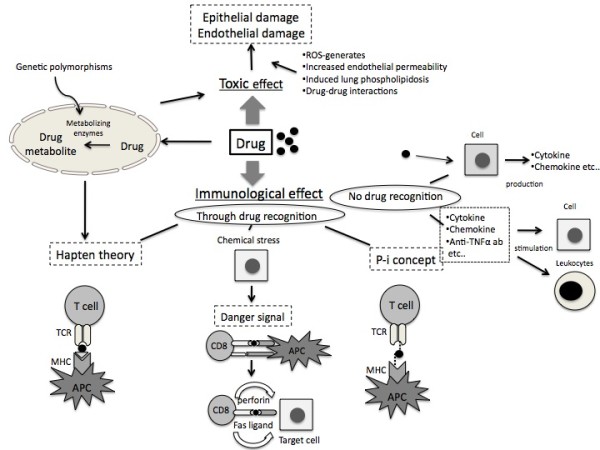
Schematic representation of drug-induced pulmonary effects and toxicity including hypothetical pathogenenic mechanisms involved.